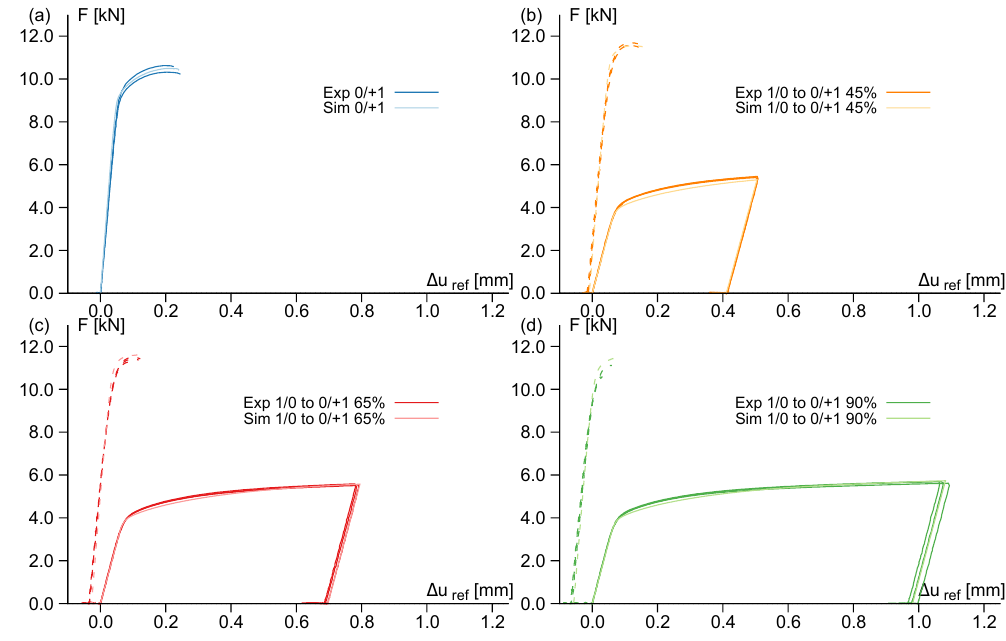
Figure 5. Load-displacement curves for F 1 / F 2 = 0/ + 1 with different